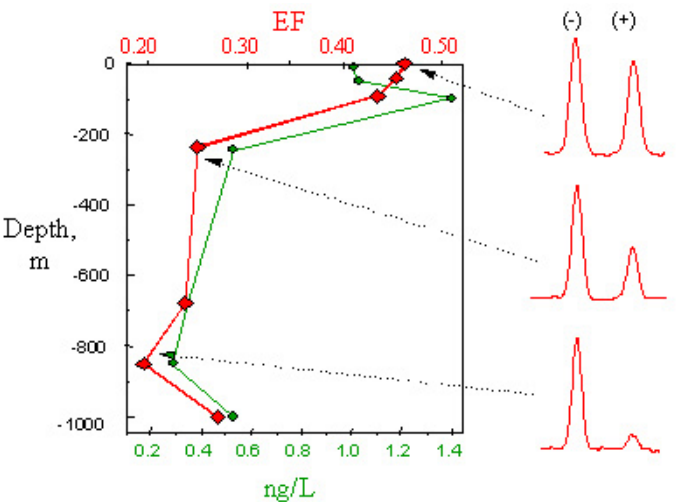
FIGURE 1. Enantiomer chromatograms (right) and vertical profiles of concentration (thin line, circles) and EF (thick line, diamonds) with depth (left) of α -HCH in the eastern Arctic Ocean. Note the preferential loss of (+) α -HCH in the deeper, older water layers. Data from Harner et